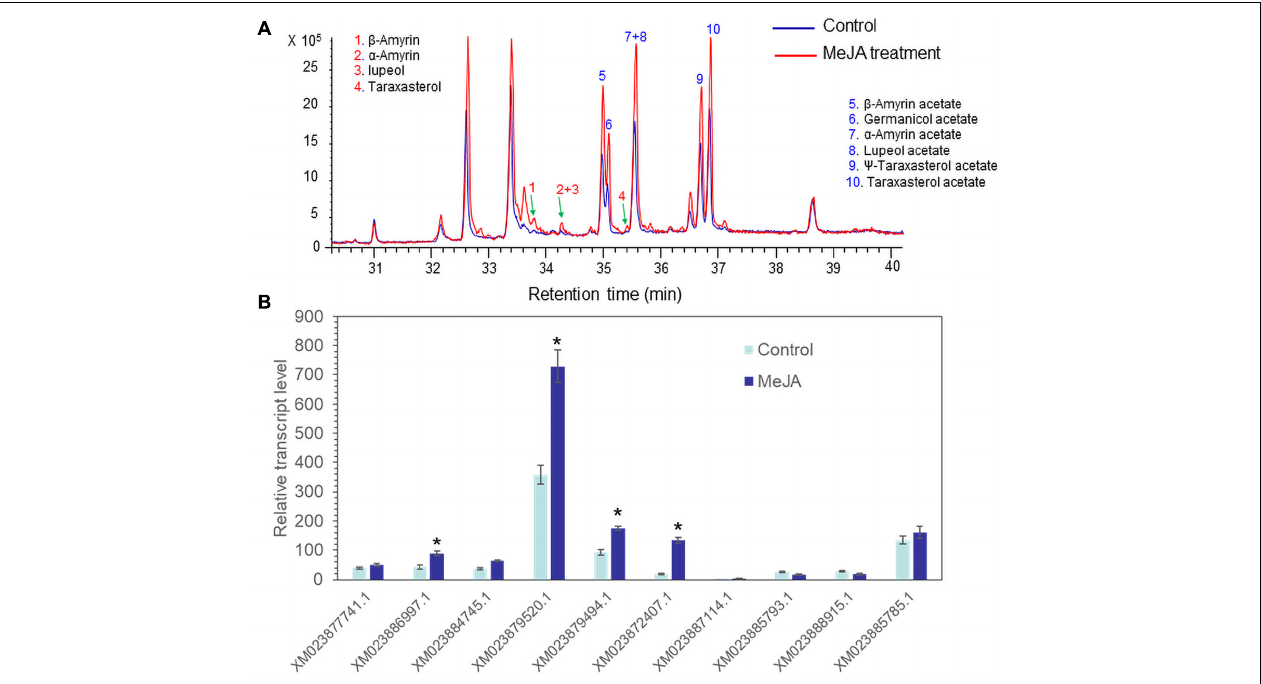
FIGURE 4 | Accumulation of triterpenes and triterpene acetates and LsTAT1 mRNA in lettuce seedlings treated with and without 100 µ M methyl jasmonate (MeJA) for 3 days. (A) GC chromatograms of extracts from control seedlings (blue line) and MeJA-treated seedlings (red line). (B ) Qantitative polymerase chain reaction (qPCR) analysis of the expression of 10 selected genes in lettuce seedlings after treatment with 100 µ M MeJA for 3 days. The data were normalized to the β -actin gene expression level. The vertical bars indicate the SEs based on three biological replicates. The asterisks indicate significant differences from the control (Student’s t -test, p <